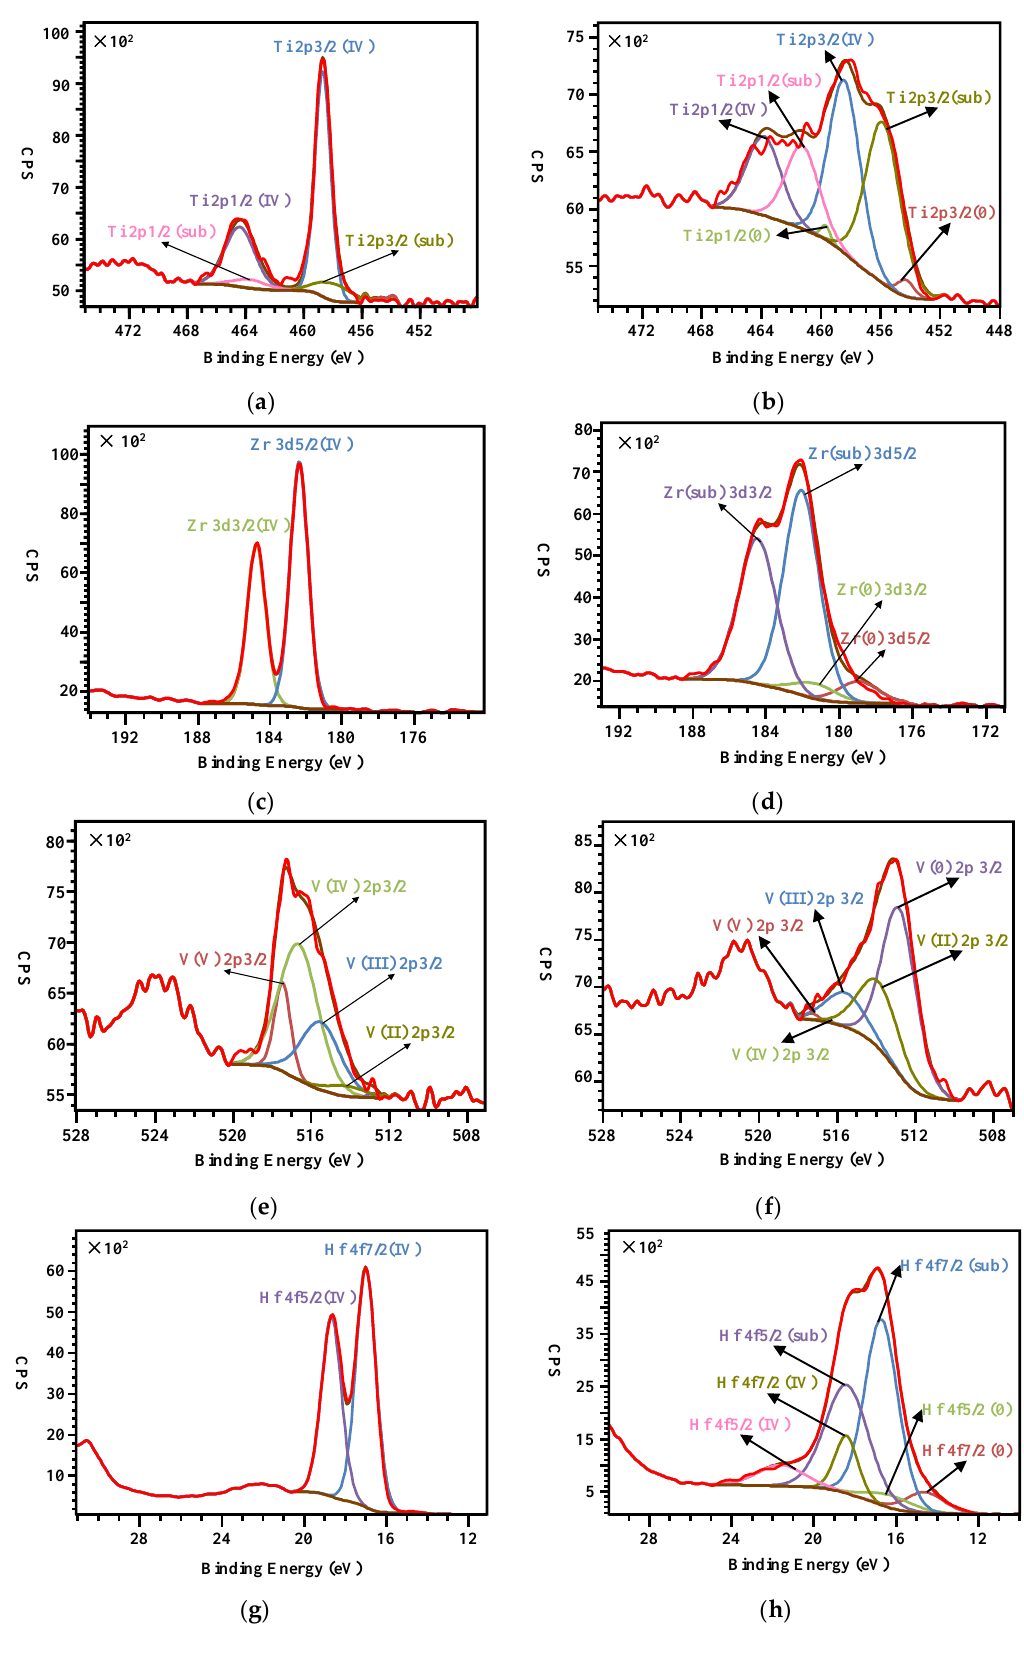
Figure 7. The XPS energy spectra of ( a ) Ti, ( c ) Zr, ( e ) V and ( g ) Hf tested at 25 °C and ( b ) Ti, ( d ) Zr, ( f ) V and ( h ) Hf tested at 150 °C of the Ti-Zr-V-Hf film with OCMF substrates, respectively.